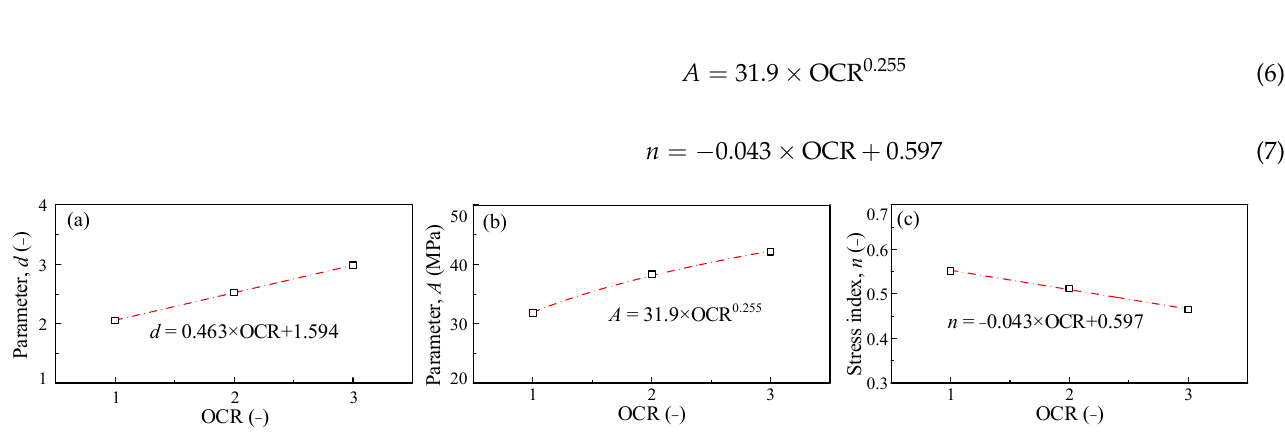
Figure 7. The relationship between parameters d, A, n, and OCR: ( a ) d versus OCR, ( b ) A versus OCR, ( c ) n versus OCR.